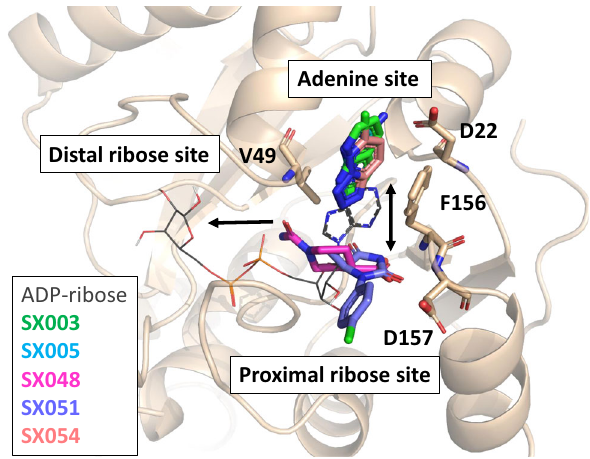
Fig. 5 SpotXplorer0 hits against the SARS-CoV-2 NSP3 macrodomain. Overlay of the binding poses of the fi ve SpotXplorer0 hits against the SARS-CoV-2 NSP3 macrodomain (colored sticks, SX003 — green, SX005 — light blue, SX048 — magenta, SX051 — purple, SX054 — orange) with the binding pose of ADP-ribose (gray lines, from PDB structure 6WOJ 60 ). Three and two hits occupy the adenine and proximal ribose sites, respectively, providing merging and growing options towards the neighboring subsites (indicated by black (Fig. 4c) with EC 50 values as low as 136 µM (for SX051) in our in vitro infection assay.